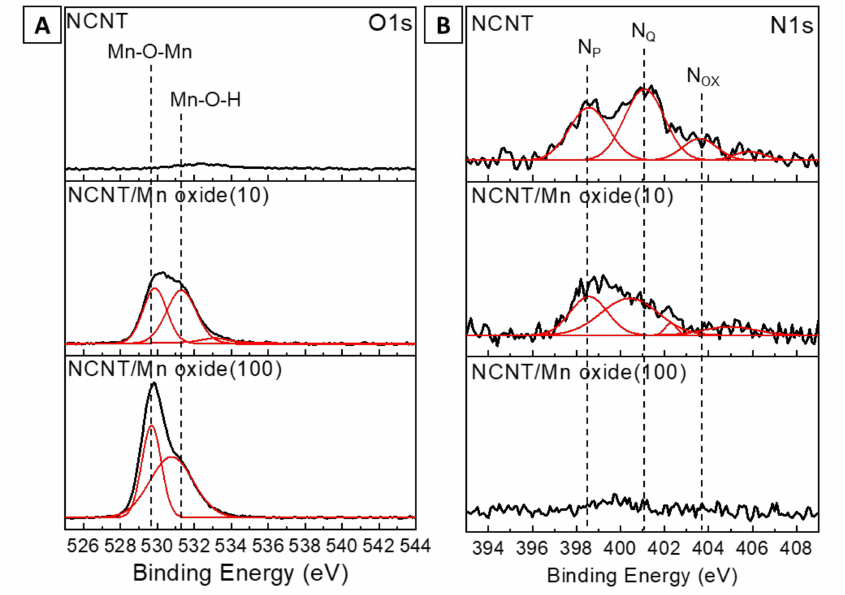
Figure 3. XPS analysis of NCNTs and MnO x /NCNT hybrids. ( A ) O1s XPS spectra. ( B ) N1s XPS spectra. The black and red lines show as-received XPS results and deconvoluted peaks, respectively. The number in parentheses indicates the molar concentration of KMnO 4 in the Mn precursor solution used for hybridization